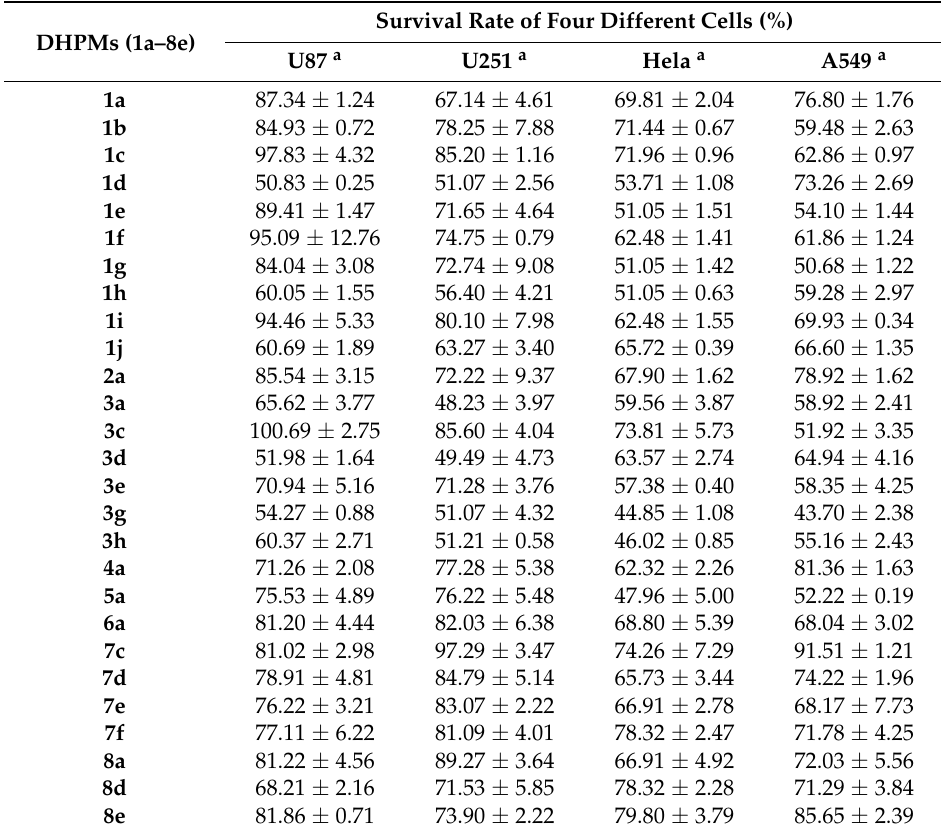
Table 2. Survival rate of all compounds against U87, U251, Hela, A549 cell lines at 72 h. DHPMs